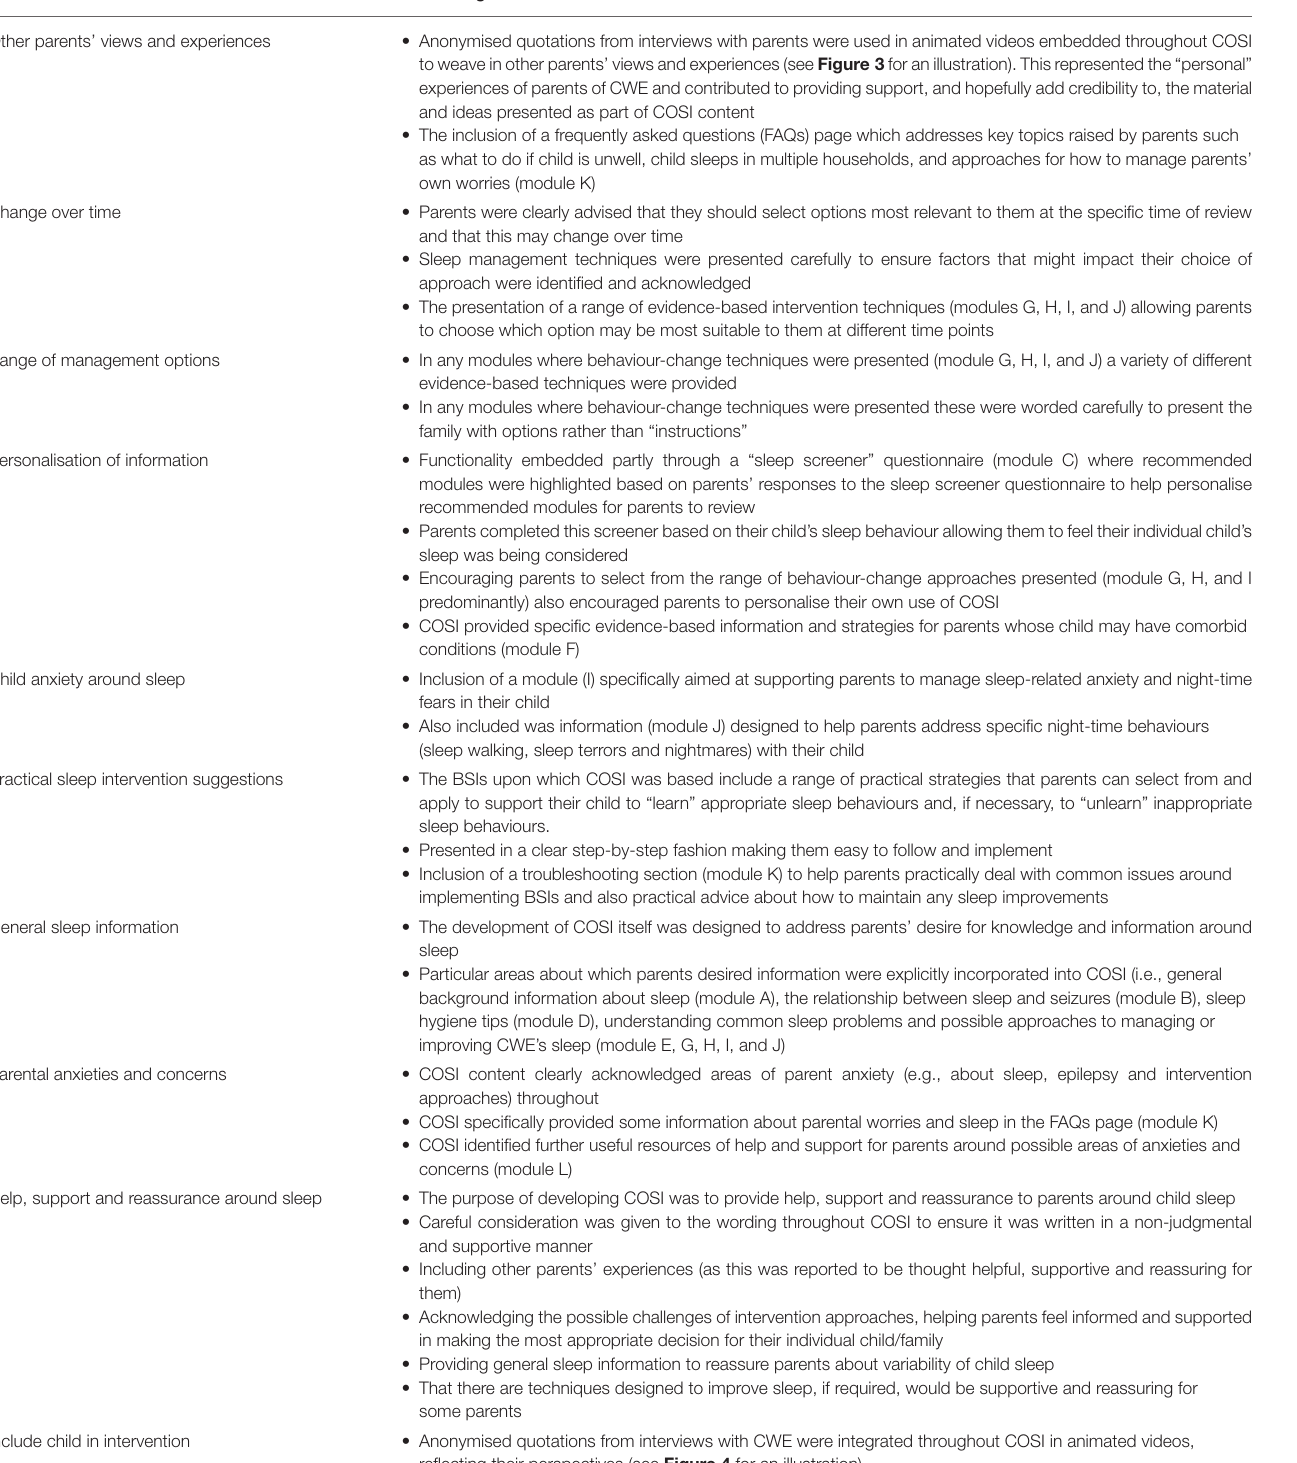
TABLE 2 | Illustration of how different themes reported by parents were integrated into